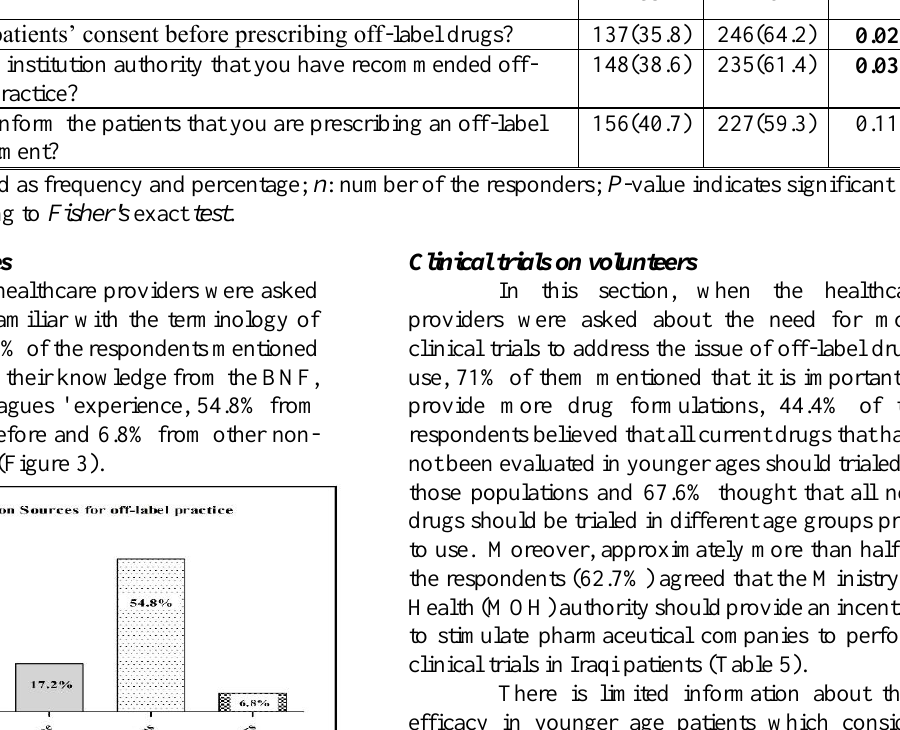
Table 4. concerns of the physicians about ask for consent for prescribe off-label drug ( n = 383 physicians) Questions